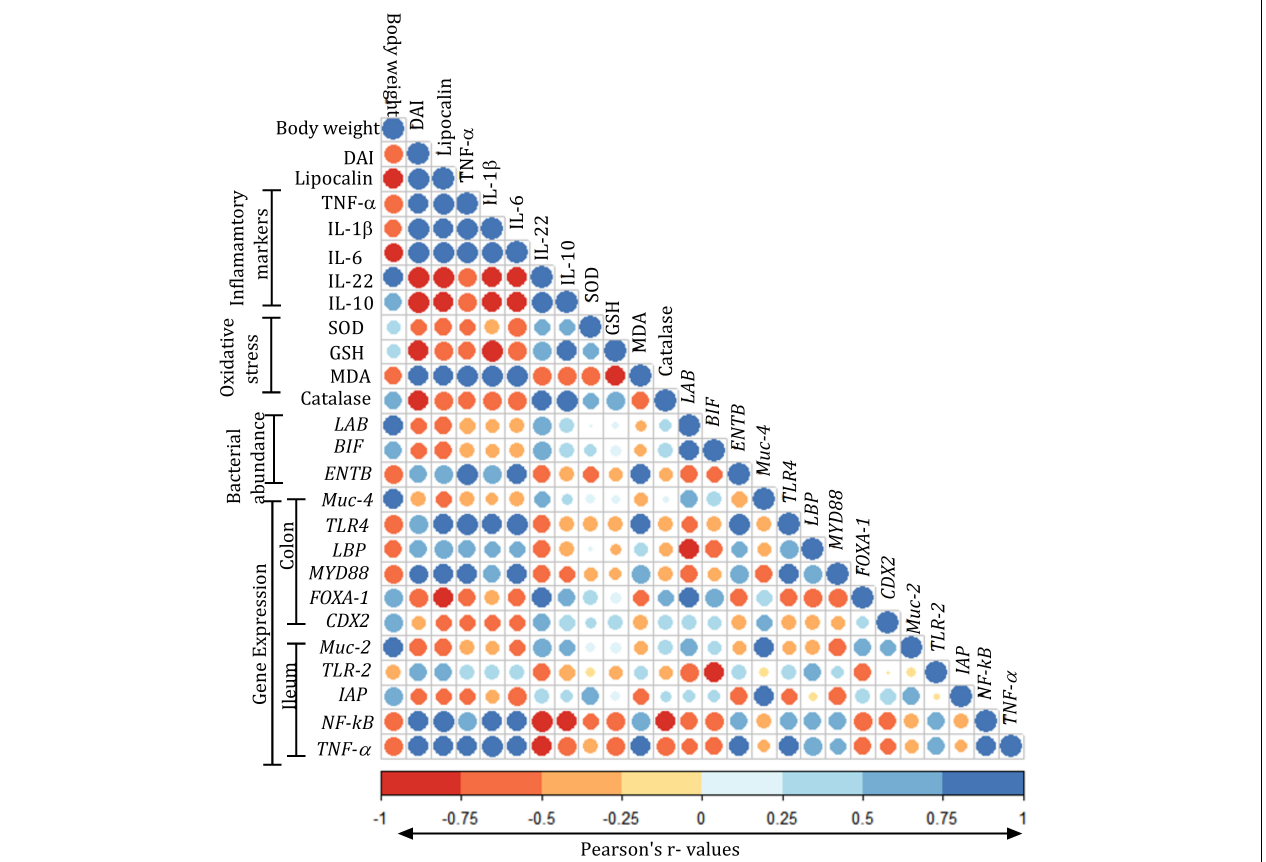
FIGURE 10 | Pearson’s correlation matrix of various parameters assessed in the study: Color gradients were given in terms of “ r ” values from Pearson’s correlation analysis for body weights (g); disease activity index (DAI); lipocalin (ng/ml); tumor necrosis factor-alpha (TNF- α , pg/ml); interleukin (IL)-1 β , IL-6, IL-22, and IL-10 (pg/ml); oxidative stress parameters: superoxide dismutase (SOD, U/mg protein), malondialdehyde (MDA, nM/mg protein), reduced glutathione (GSH, pM/mg protein), superoxide dismutase (SOD, U/mg protein), catalase (U/mg protein); expression of Lactobacillus (LAB), Bifidobacteria (BIF), Enterobacteriaceae (ENTB), muc gene ( MUC-4 ), toll-like receptor-4 ( TLR-4 ), LPS-binding protein ( LBP ), myeloid differentiation factor ( MYD88 ), forkhead box protein ( FOXA-1 ), caudal type homeobox 2 ( CDX2 ) in the colon, expression of genes muc gene ( MUC-2 ), toll-like receptor ( TLR2 ), intestinal alkaline phosphatase ( IAP ), nuclear factor- κ beta ( NF-kB ), and tumor necrosis factor-alpha ( TNF- α ) in the ileum. All the values are expressed as